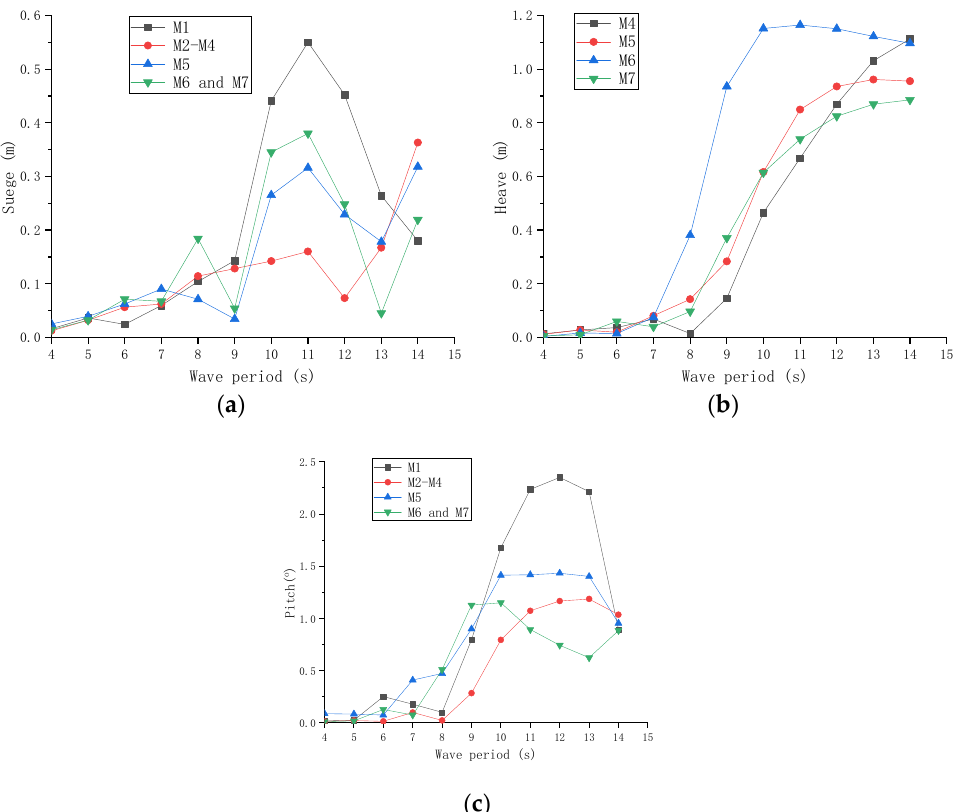
Figure 13. Numerical results of main motion responses of each module under 180° incident wave: ( a ) surge; ( b ) heave; and ( c ) pitch. ( a ) surge; ( b ) heave; and ( c )